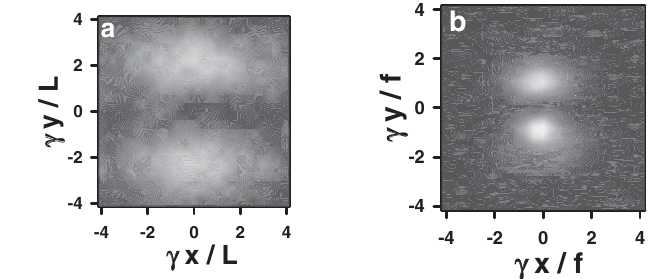
FIG. 18. (a) OTR 2D spatial distributions in the PWZ mea- sured with 350 nm (solid line) and 600 nm (dashed line) filters without the lens ( f (cid:5) 0 : 2 m ). (b) OTR 2D spatial distributions calculated for 350 nm (solid line) and 600 nm (dashed line).